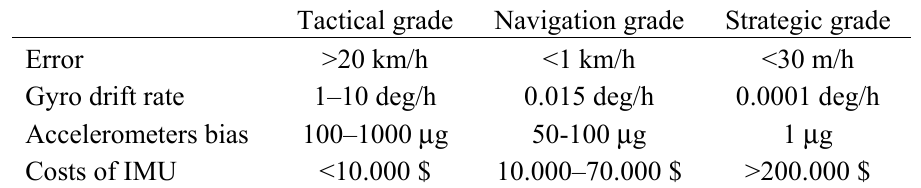
Table 1. Sensing performance requirements for IMU in three aerospace fields with increasing